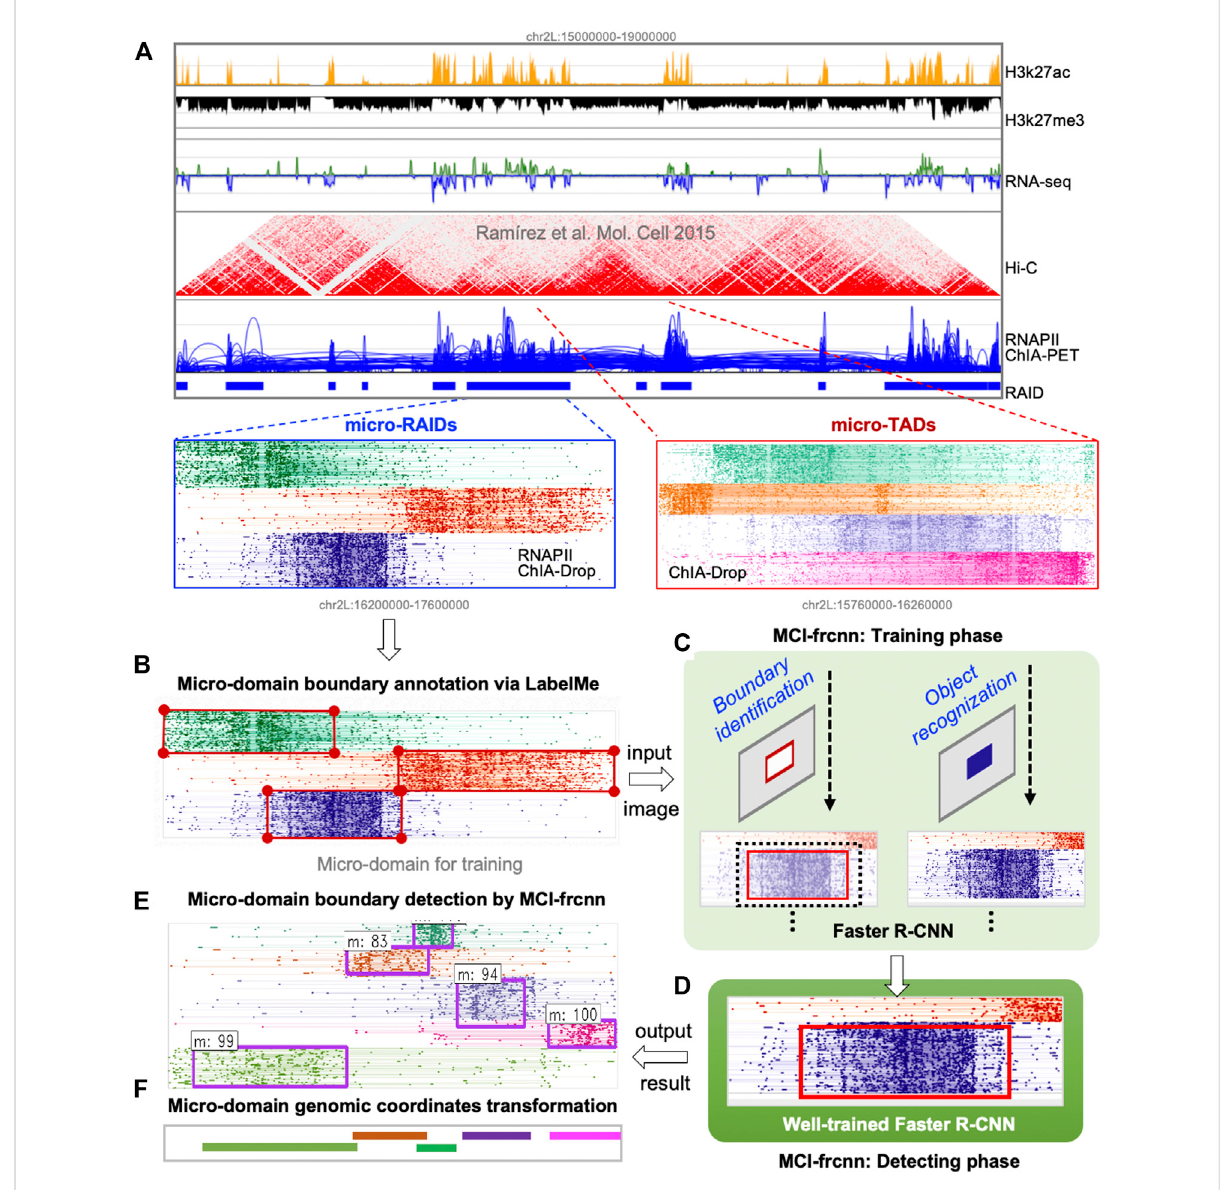
FIGURE 1 SchemeofMCI-frcnn. (A) Using theclustering algorithmbasedvisualization tool MCIBox,wedissected RNAPII-associated interactiondomains (RAIDs) fromChIA-PETdata intomicro-RAIDs byRNAPII-enriched ChIA-Dropdata,anddissolved topologically associateddomains(TADs)fromHi- C data into micro-TADs by ChIA-Drop data. (B) An imageof a RAID with clustered fragment-view ofmicro-domains for the MCI-frcnn training set is subjected to LabelMe annotation tool to draw their ground truth boundary boxes. (C) MCI-frcnn trains Faster R-CNN networks using a training set for boundary identi fi cation and recognition of a micro-domain. (D) After a number of epochs (iterations) of training and fi netuning, the Faster R-CNNnetworksaretrainedandreadyfordetection. (E) Boundaries(boundingboxes)ofmicro-domainsdetectedbyMCI-frcnnfromnewimagesof the detecting set, with a detected class name and a classi fi cation score. (F) Micro-domain genomic coordinates transformed from pixel boundary